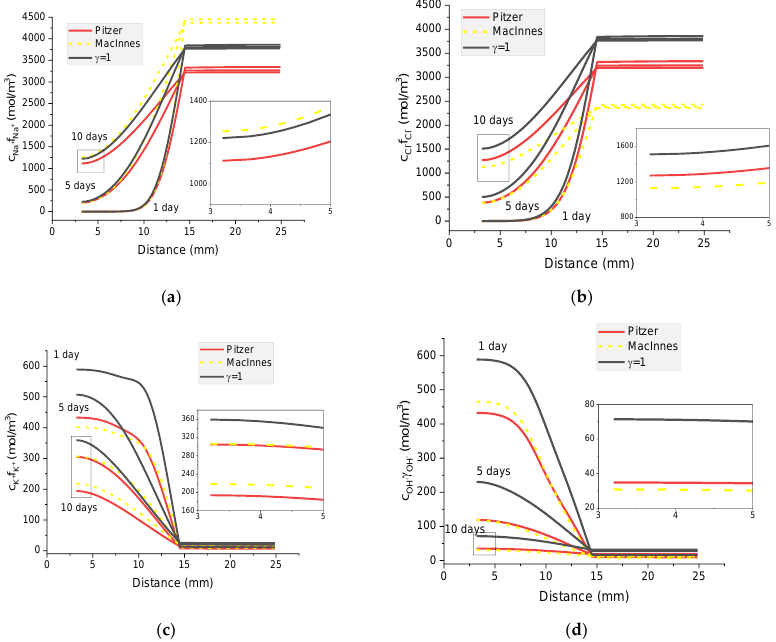
Figure 14. Calculated activity profiles of ions in the mortar immersed in 20 wt% NaCl water solution. ( a ) Na + ; ( b ) Cl − ; ( c ) K + ; ( d ) OH − for the Pitzer model and MacInnes scaling — comparison with ions concentrations ( γ = 1).